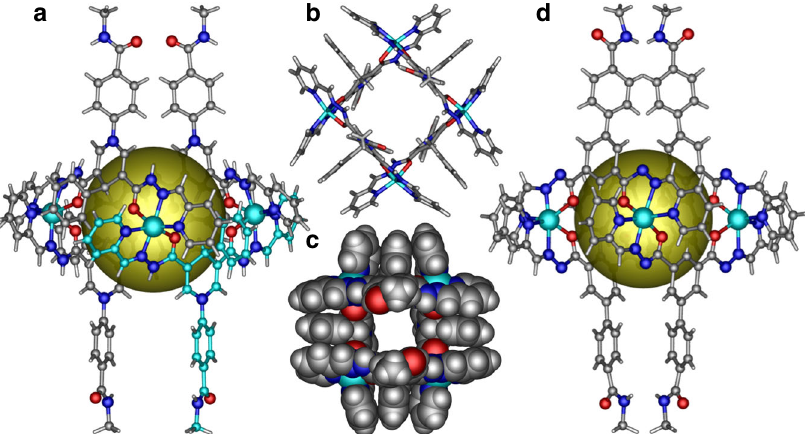
Fig. 2 Crystal structures of the molecular macrocycle hosts. a Crystal structure of the macrocycle Zn – ZPA showing the coordination geometry of the zinc ions, the pocket and the distribution of the NADH-mimicking active sites and amide groups on the H 2 ZPA ligands. b Top view and c space- fi lling pattern of the macrocycle Zn – ZPA showing the resulting con fi ned space and the open channels. d Crystal structure of the macrocycle Zn – PMA . Zn: cyan, O: red, N: blue, C: gray and H: white. Solvent molecules and counter ions are omitted for